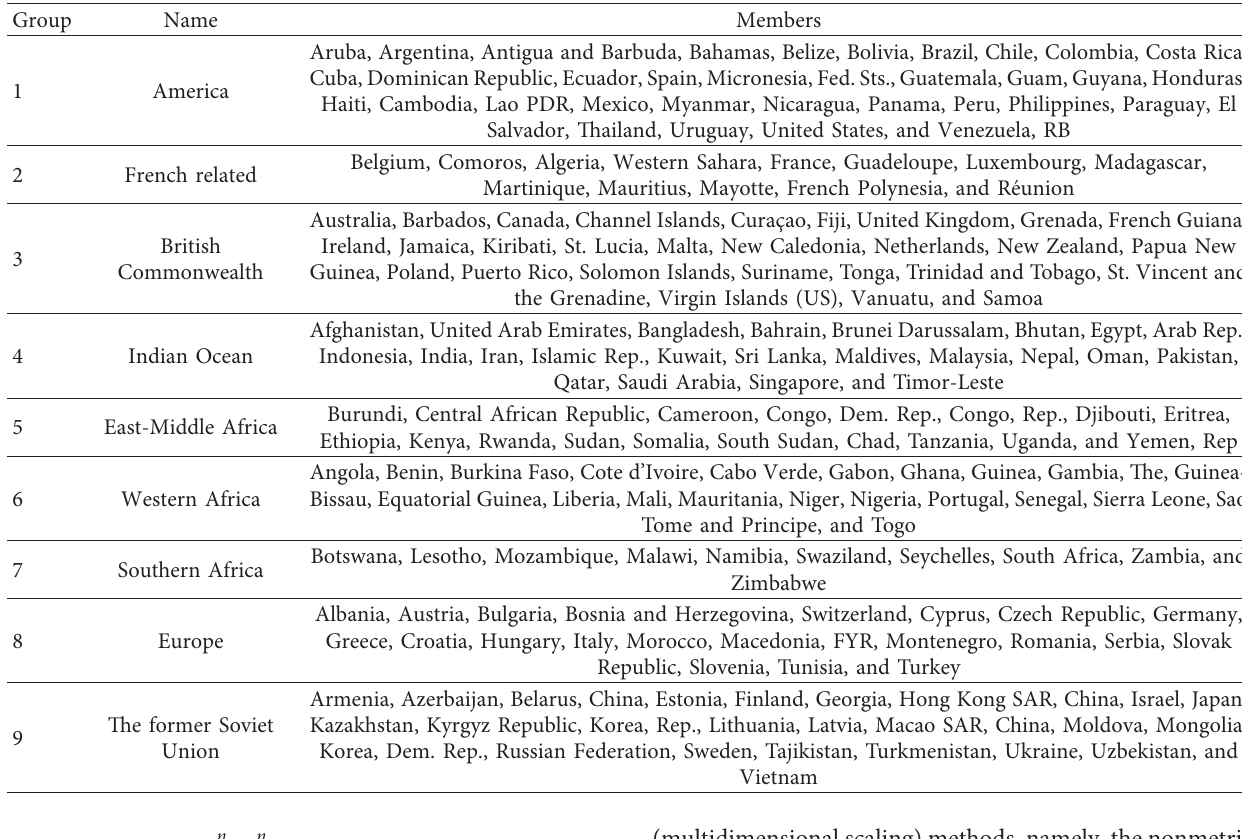
Table 2: Community of GMN in